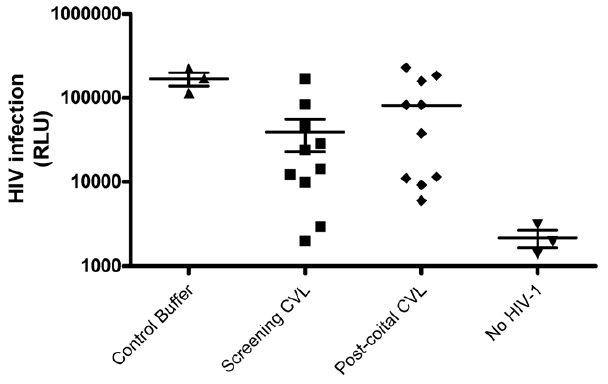
Figure 2. Endogenous anti-HIV activity in CVL collected in the absence or following coitus. TZM-bl cells were infected with 10 3 TCID 50 HIV-1 BaL in the presence of Visit 1 (baseline) or Visit 2 (postcoital) CVL or control buffer (saline with 1.5 mg/ml bovine serum albumin). Mock infected cells were included as controls. Results are mean RLU obtained from 2 independent experiments, each conducted in triplicate.